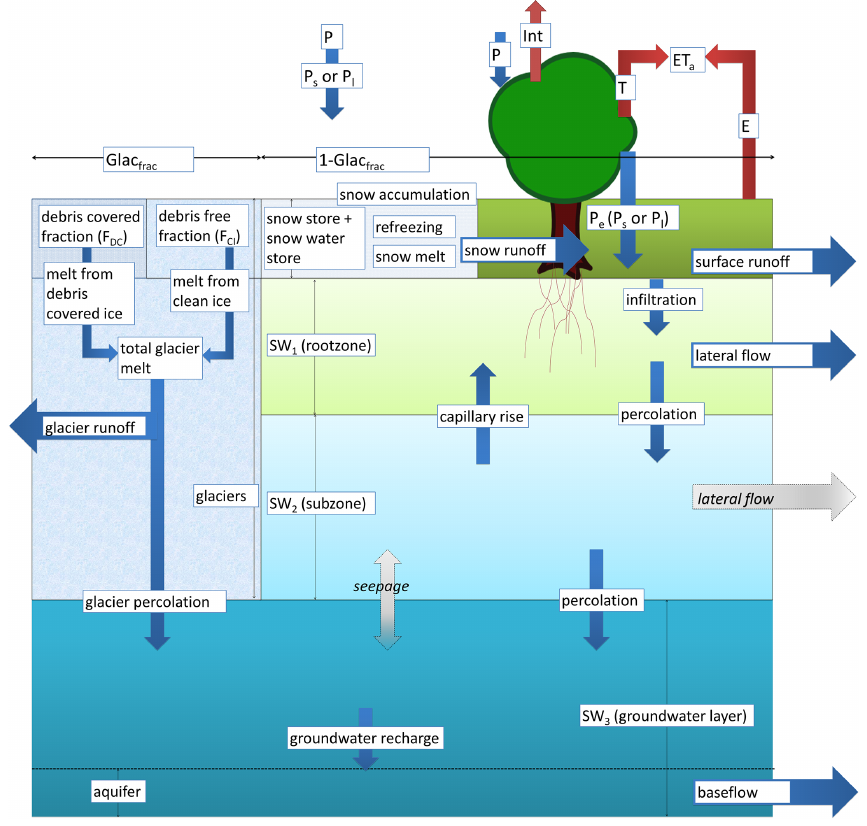
Figure 2. SPHY modeling concepts. The fluxes in grey are only incorporated when the groundwater module is not used. Abbreviations are explained in the